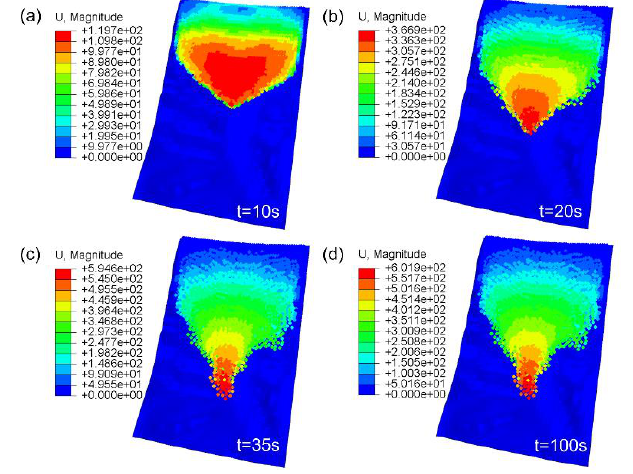
Figure 11. Total displacement (U-Magnitude) contour of the landslides for the full high waste dump at ( a ) t = 10 s; ( b ) t = 20 s; ( c ) t = 35 s and ( d ) t = 100 s. Next, the velocity contours (V-Magnitude) from t = 1 s to t = 100 s are given in Figure 12. It is